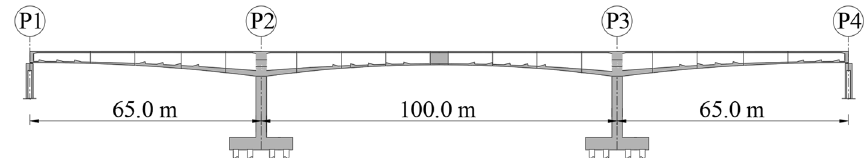
Fig. 17 Elevation of Talkha Bridge over the Nile River